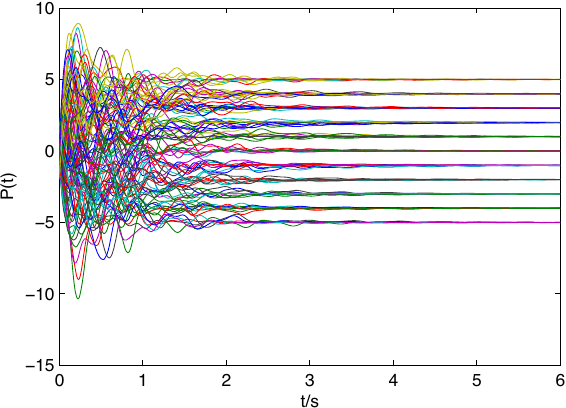
Fig. 1 The response curves of nodes’ state x